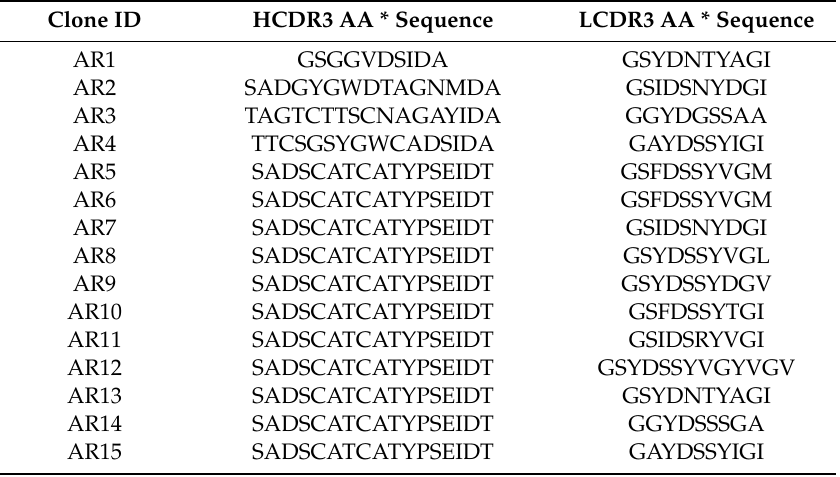
Table 2. Amino acid sequences of AR CDR3 clonotypes identified from AR